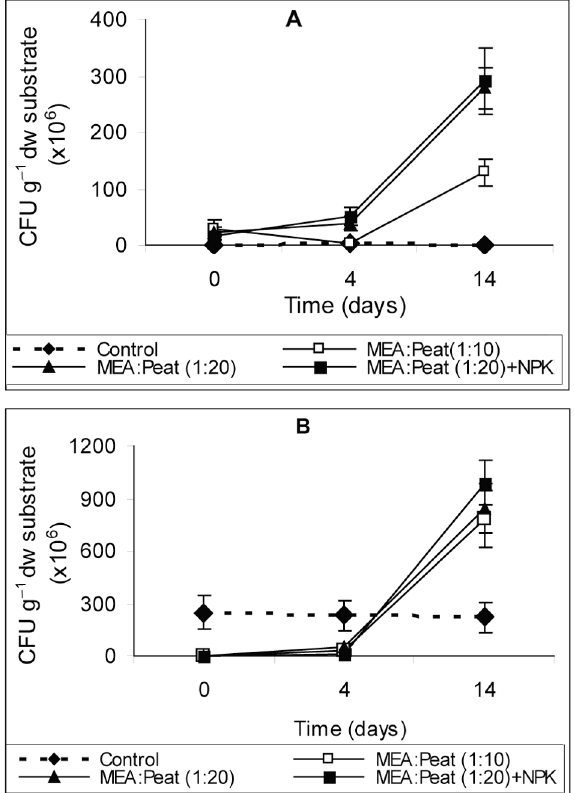
Fig. 2. The number of ammonifying bacteria in MEA and peat (A – pH 3,1; B – pH 6,3) mixed